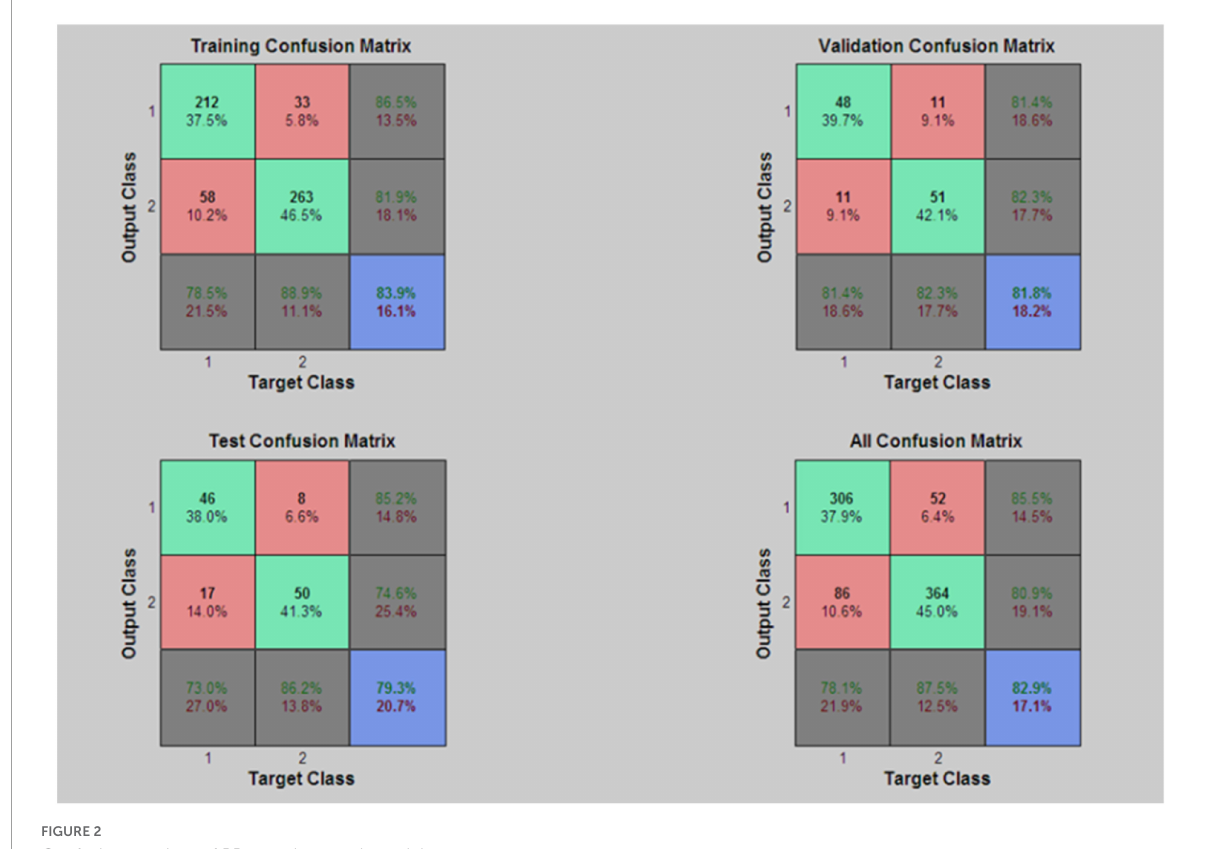
FIGURE2 Confusion matrixes of BP neural network model.